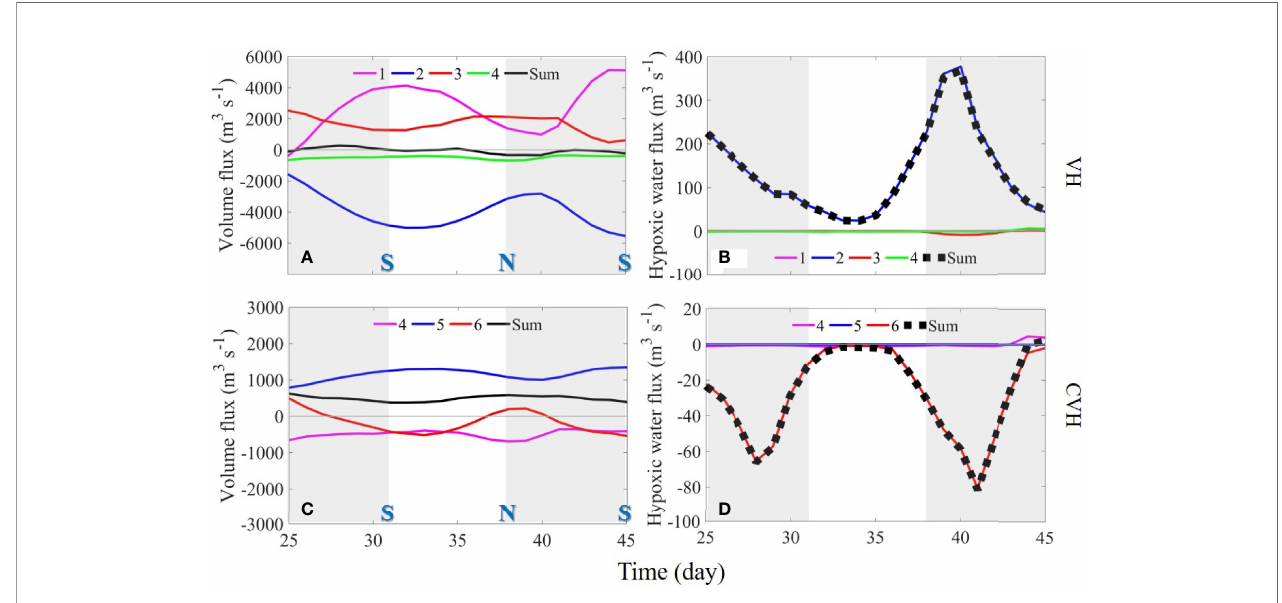
FIGURE 7 | Time-series of (A, C) volume and (B, D) hypoxic water fl uxes through sections 1 – 4 (VH; upper panel) and sections 4 – 6 (CVH; lower panel). Positive and negative values represent volume or DO fl uxes into and out of the VH. “ S ” and “ N ” refer to the spring and neap tides, respectively. Note that the scales used for the CVH are smaller in the fi